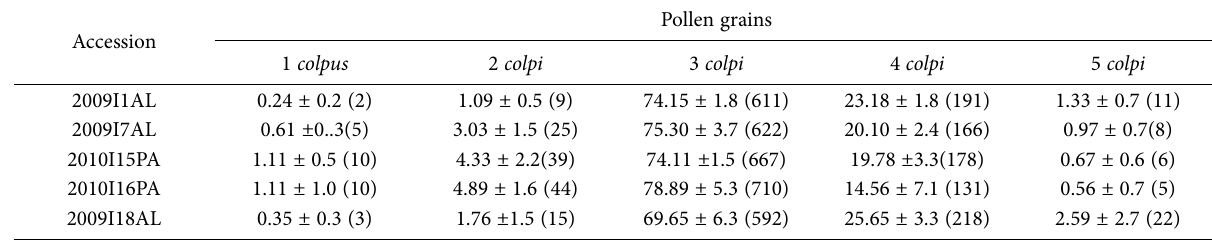
Table 2. Percentage of pollen grains morphotypes in L. algarvense . The percentage of each of the different pollen types and standard devia- tion is indicated.